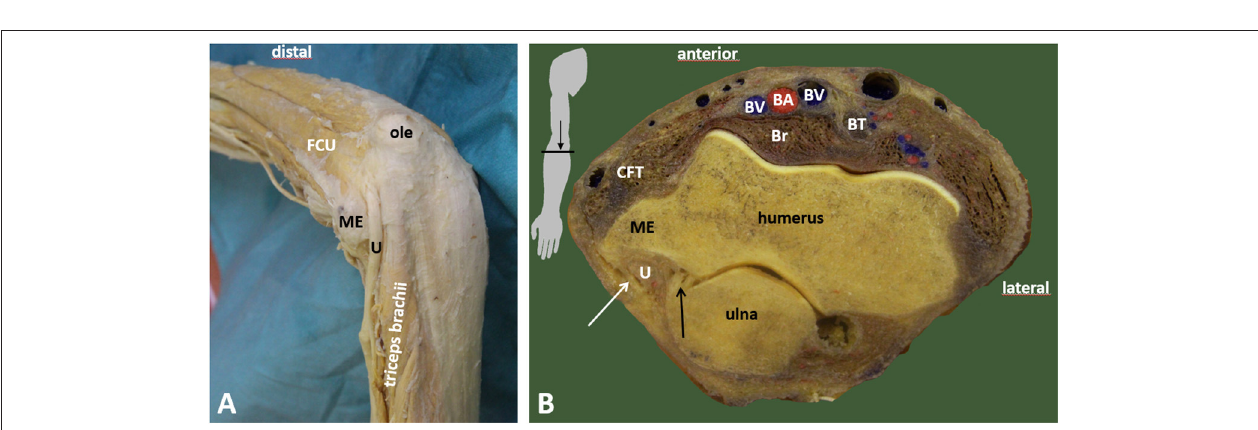
FIGURE 3 | Retroepicondylar groove and the entrance to the cubital tunnel. (A) Entrance of the ulnar nerve to the cubital tunnel. (B) Demarcation of the cubital tunnel. BA, brachial artery; Br, brachialis muscle; BT, biceps brachii muscle tendon; BV, brachial vein; CFT, common flexor tendon; FCU, flexor carpi ulnaris muscle; ME, medial epicondyle; ole, olecranon; U, ulnar nerve; black arrow, medial collateral ligament, posterior bundle; white arrow, retroepicondylar